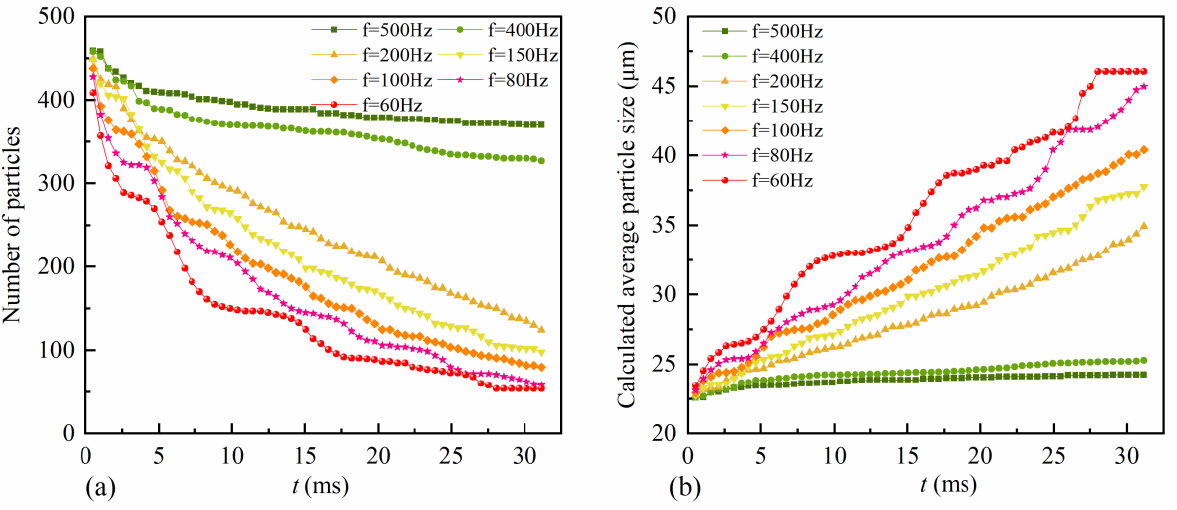
Figure 7. Simulation of acoustic agglomeration process of aerosol droplet particles under sound waves of SPL = 100 dB: ( a ) decreasing process of the number of particles, ( b ) growth process of the calculated average particle sizes.